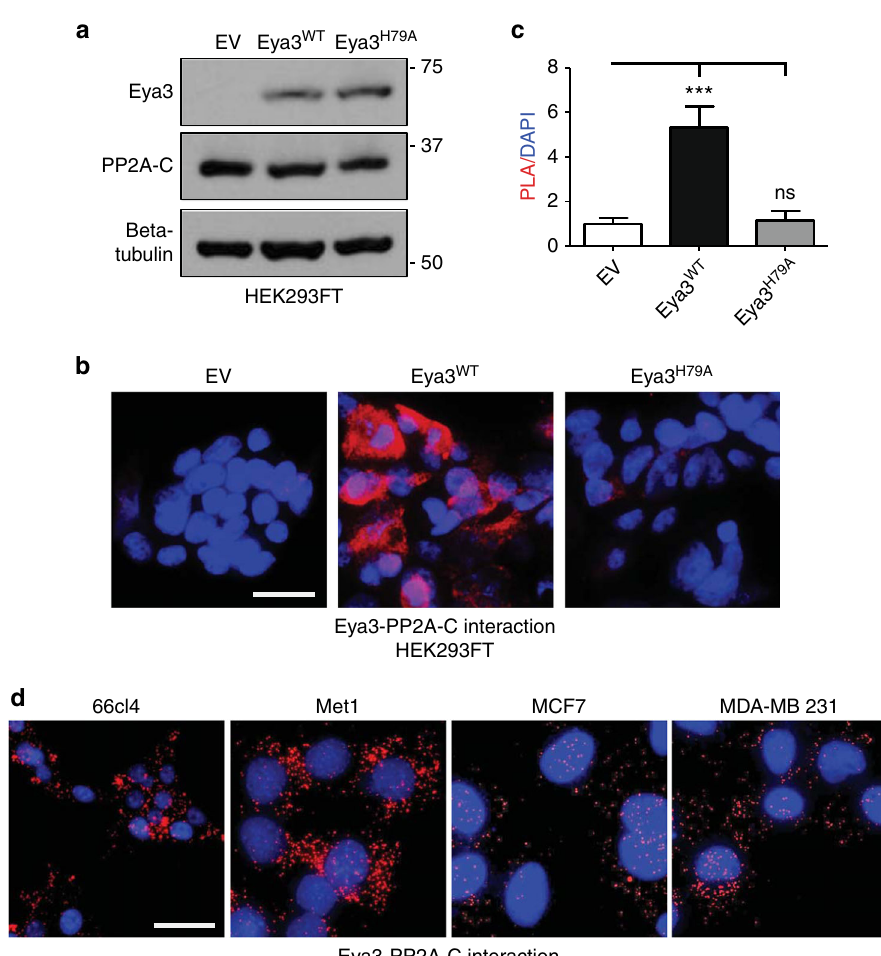
Fig. 2 The Eya3 – PP2A association is disrupted by the Eya3 H79A mutation in cells, and can be observed in the endogenous context. a Western blot analysis on whole cell lysates demonstrates levels of exogenous Eya3, as detected with an anti-Eya3 antibody, expressed in HEK293FT cells transfected with empty vector (EV), Flag-Eya3 WT or Flag-Eya3 H79A . Molecular weight markers in kilodalton are labeled on the side of western blots. b Representative images of proximity ligation assay (PLA) demonstrating the association between Eya3 and PP2A-C in HEK293FT cells transfected with EV, Eya3 WT , or Eya3 H79A are shown, scale bar: 20 μ m. c Quanti fi cation of relative PLA/DAPI signal ratio in b , EV group is set to 1 and p -value is calculated using one-way ANOVA followed by Tukey test, *** p < 0.001, error bars: standard deviations (SD), n = 5. d Representative PLA images examining the endogenous Eya3 – PP2A-C association in multiple mouse and human breast cancer lines: 66cl4, Met1, MCF7, and MDA-MB-231 are shown, scale bar: 20 μ